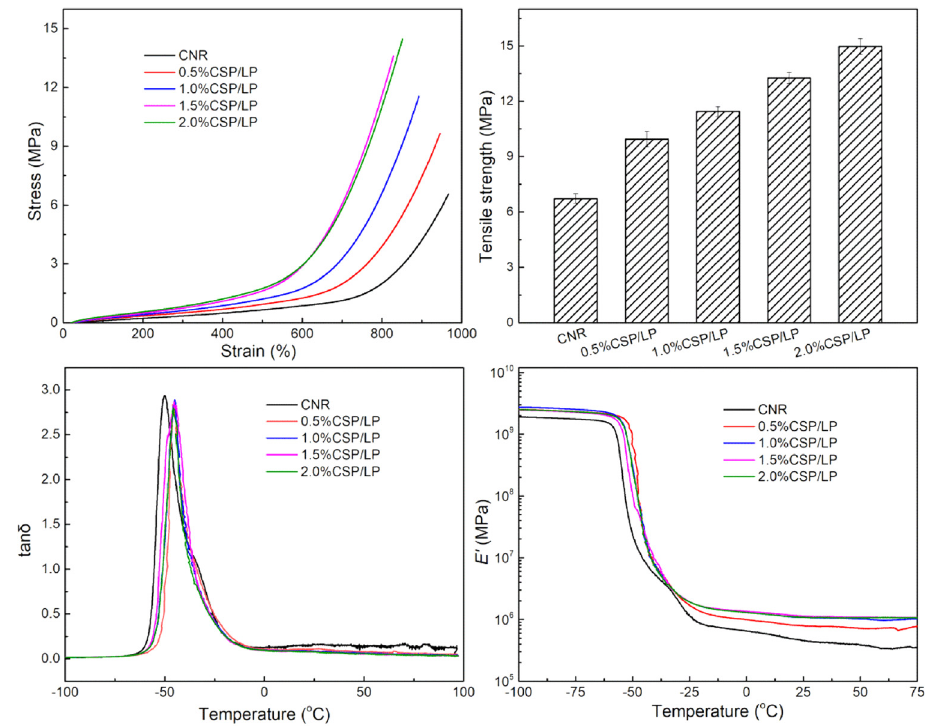
Figure 6: ( a ) Stress – strain curves of vulcanized NR with di ff erent protein contents; ( b ) tensile strength of vulcanized NR with di ff erent protein contents; ( c ) the temperature - dependent curves of tan δ for samples with di ff erent protein contents; ( d ) the temperature - dependent curves of E ʹ for samples with di ff erent protein